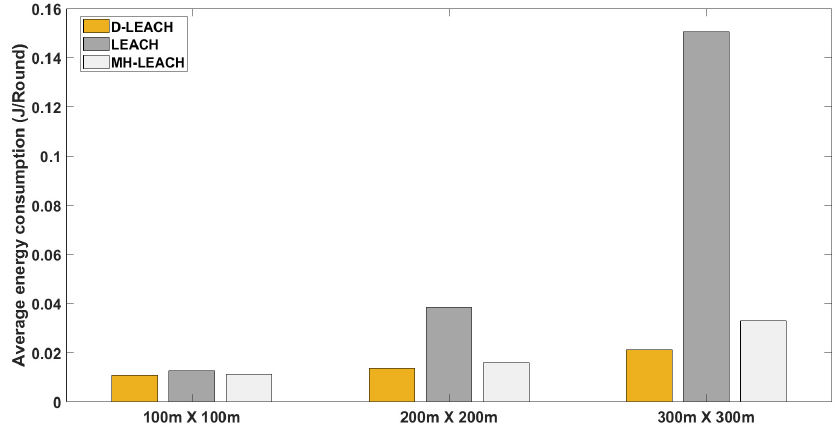
Figure 17. The average amount of energy used per round.